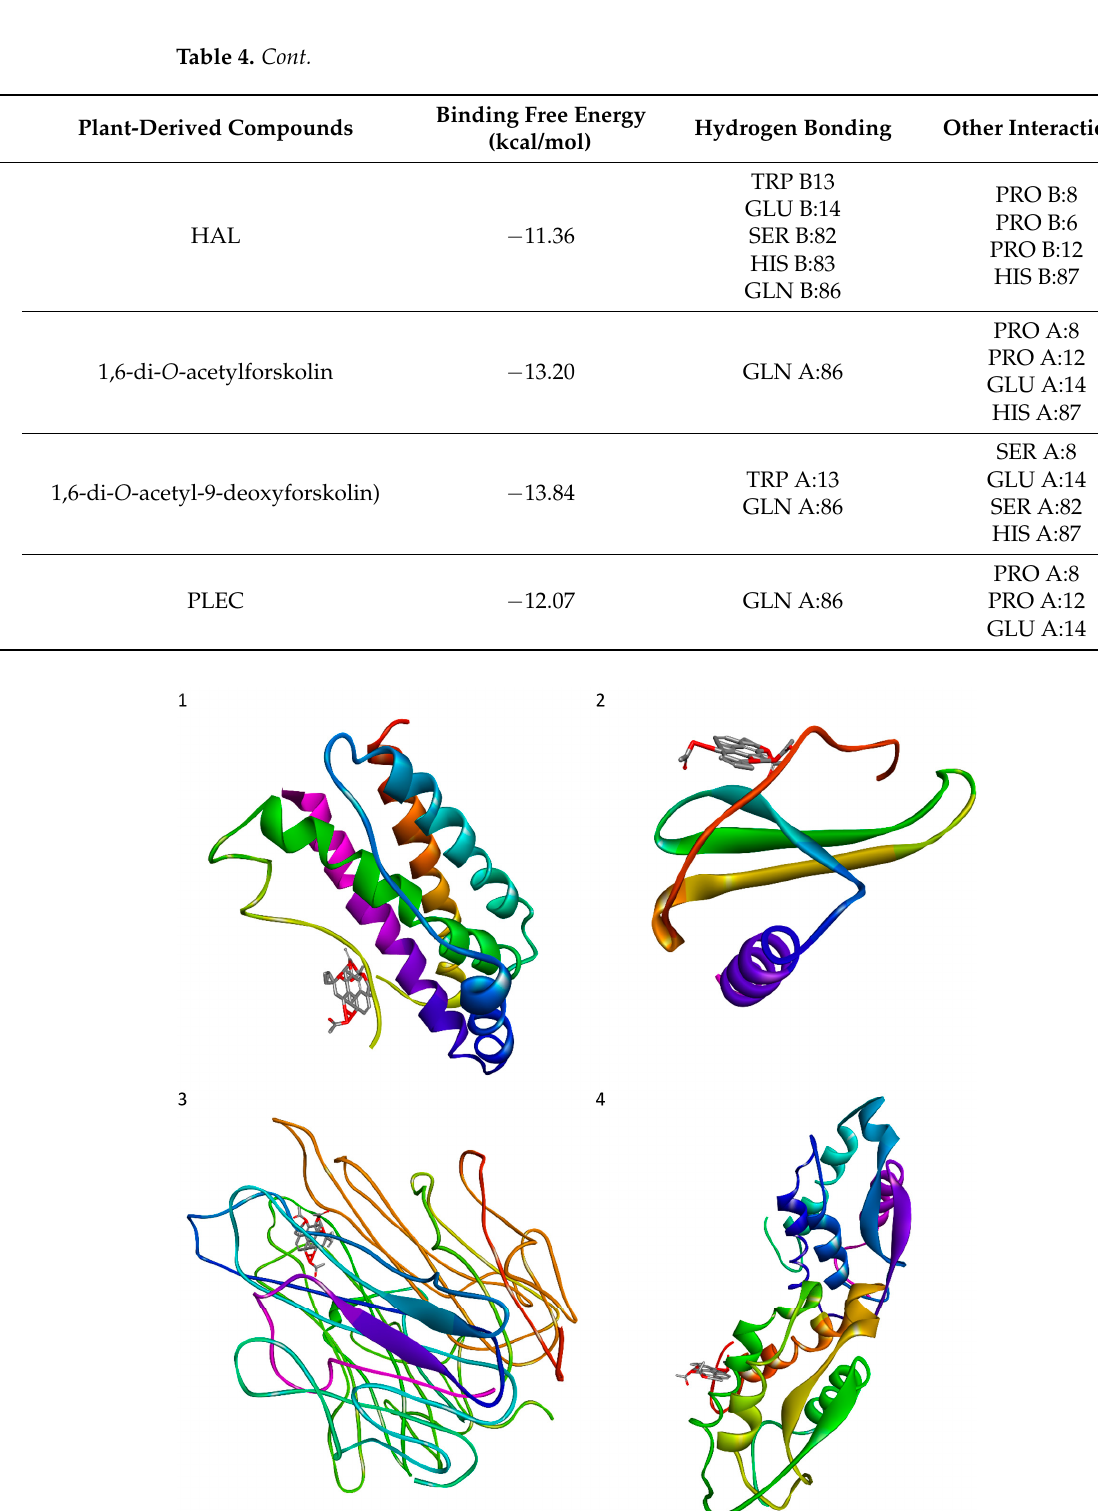
Figure 10. Diterpenes dock into targeted proteins with the lowest energy: ( 1 ) IL-6 with 1,6-di- O - acetyl-9-deoxyforskolin; ( 2 ) IL-8 with 1,6-di- O -acetylforskolin; ( 3 ) TNF- α with 1,6-di- O -acetyl-9- deoxyforskolin; ( 4 ) GM-CSF with 1,6-di- O -acetyl-9-deoxyforskolin. The evaluated binding energies ranged from − 16.26 to − 10.33 kcal/mol. The lowest binding energy was exhibited by 1,6-di- O -acetyl-9-deoxyforskolin docked into IL-6, TNF- α and GM-CSF, as well as 1,6-di- O -acetylforskolin docked into IL-8. Overall, all